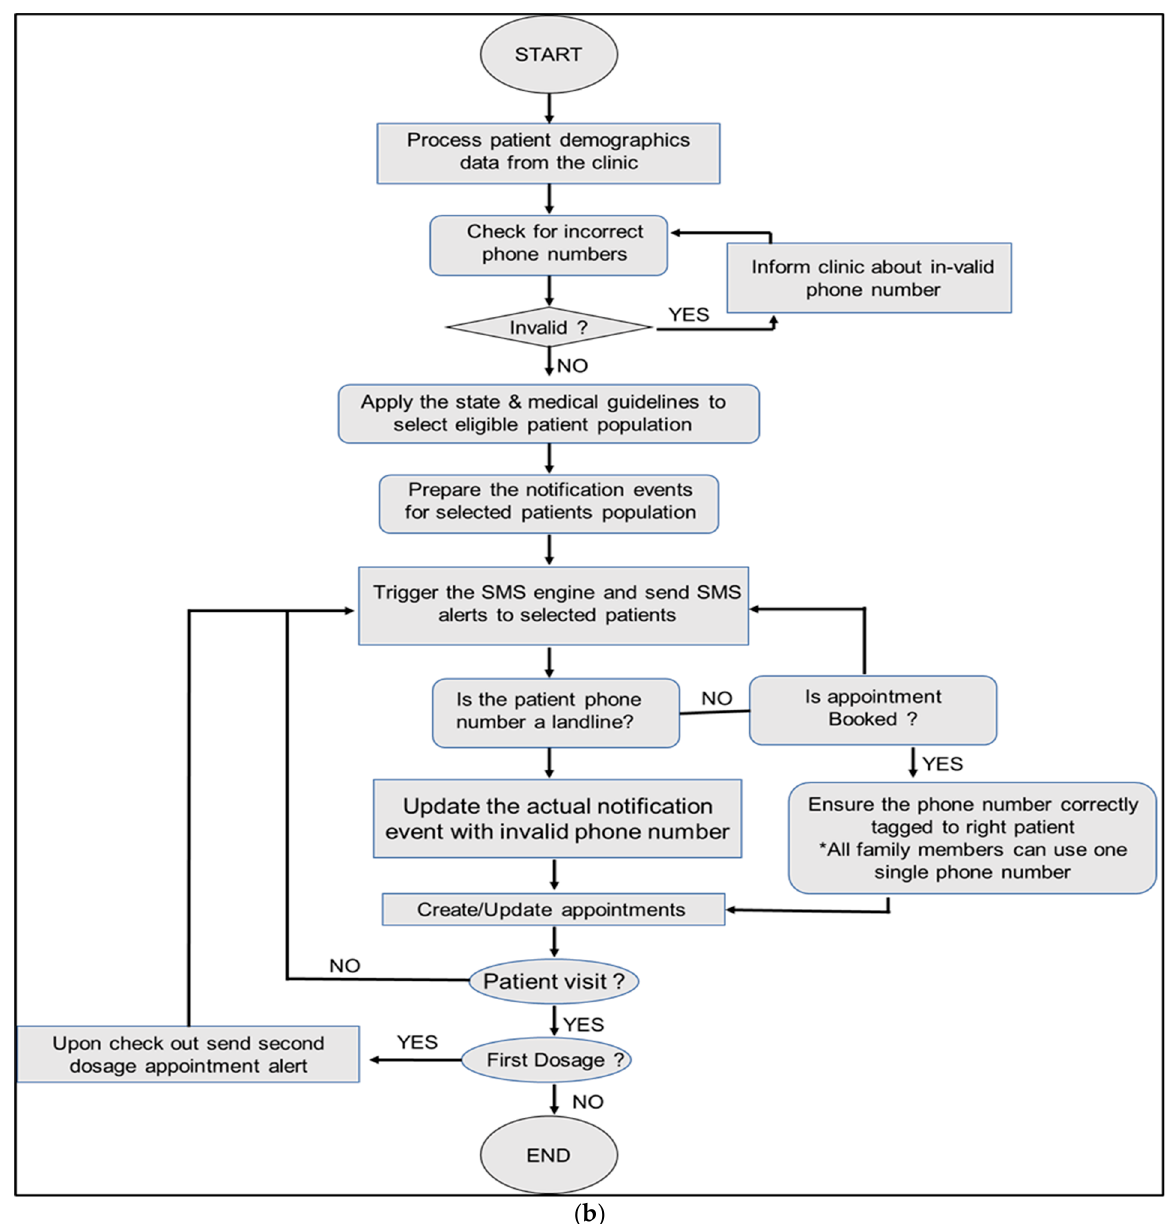
Figure 1. ( a ) Clinical workflow of patients and staff. ( b ) Architecture of the self-scheduling